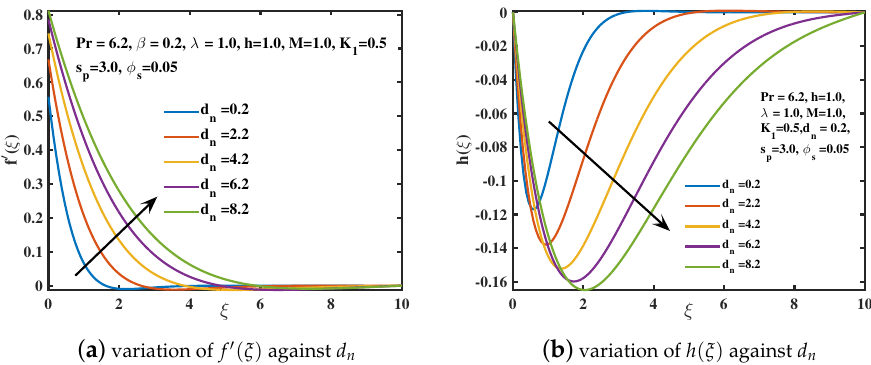
Figure 7. The f (cid:48) ( ξ ) and h ( ξ ) curves for distinct diameter d n values.